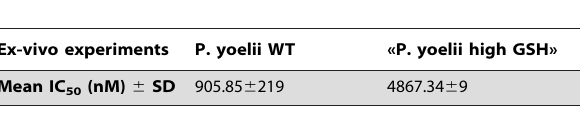
Table 4. Ex-vivo experiments: short-term culture of P. yoelii with ellagic